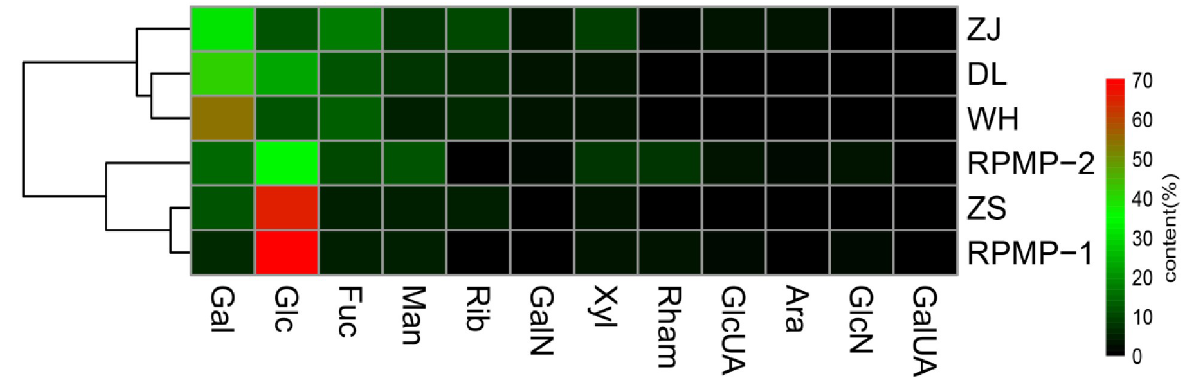
Fig 2. Heat map showing the clustering of the RPM polysaccharide compositions from four Chinese coastal